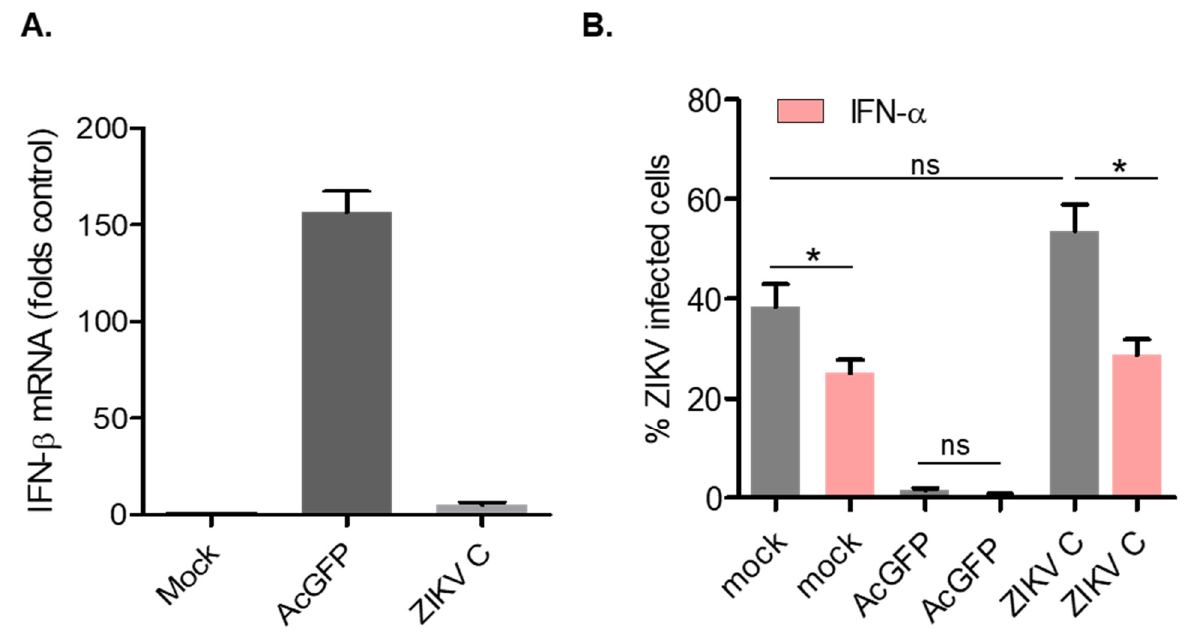
Figure 4. ZIKV capsid expressing cells suppress IFN- β and are highly susceptible to infection. A549 cells were transduced with lentivirus expressing AcGFP or AcGFP-Myc-ZIKVC (MOT of 10). ( A ) AcGFP expressing cells have high levels of IFN- β mRNA. Cells were collected at 48 h post-transduction and the levels of IFN- β mRNA in mock, AcGFP or ZIKV C-expressing cells were determined by qRT-PCR. ( B ) ZIKV C expressing cells are permissive to ZIKV infection but are sensitive to pre-treatment with IFN- α . Transduced cells were infected with ZIKV at an MOI of 3 (grey bars) or pre-treated with IFN- α prior to ZIKV infection (pink bars). All cells were collected 48 h post-infection and stained with anti-ZIKV NS1 antibody. Only the GFP-positive cells were included in the analysis. Average results from 3 independent experiments are shown. Results of statistical analyses ( t -test) are indicated (* p ≤ 0.05). ns, not significant.